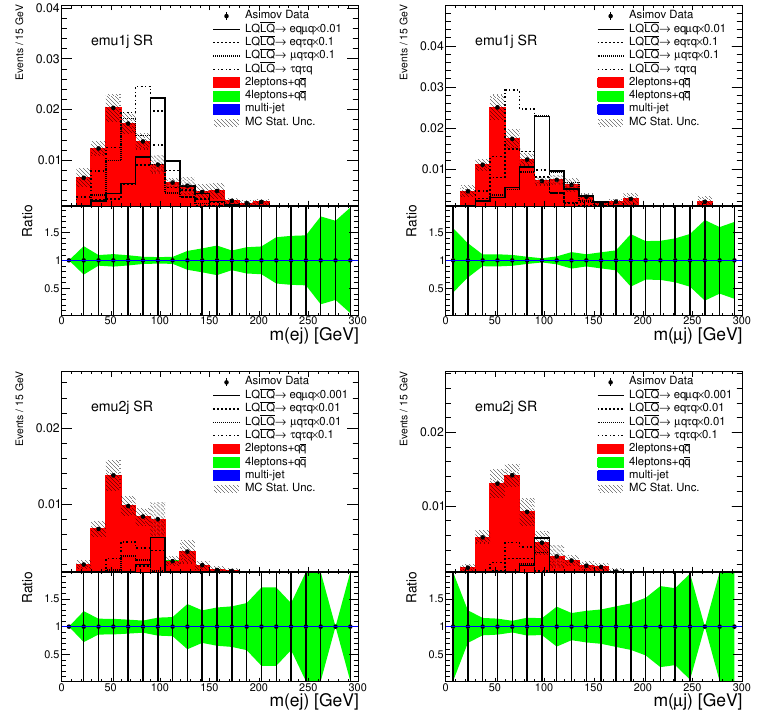
Figure 3 . The distribution of the invariant mass of a lepton candidate and a jet candidate in the signal region “emu1j” (top) and “emu2j” (bottom). The left one is m ( ej ) and the right one is m ( µj ) . The black points in the upper pads show the asimov data which is just the sum of all background events with uncertainties completely suppressed for better illustration. The ratio of the asimov data and the total background is shown in the lower pads, where the error bars on the black points represent the expected data uncertainty while the green bands represent the total MC statistical uncertainty.